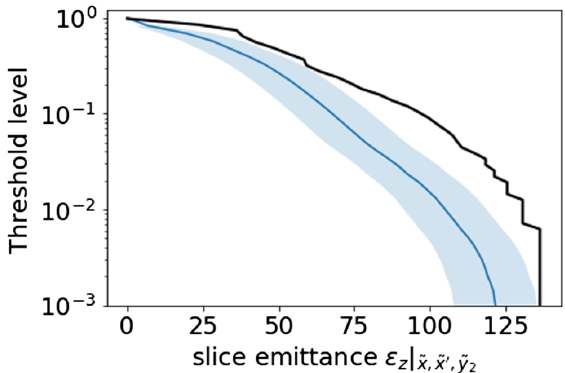
FIG. 14. Dependence of measured (blue curve, with uncertainty interval) and simulated slice emittances (black curve) for slice ˜ x; ˜ x 0 ; ˜ y ¼ 0 . The correction to point-spread error is applied to 2 measured values.